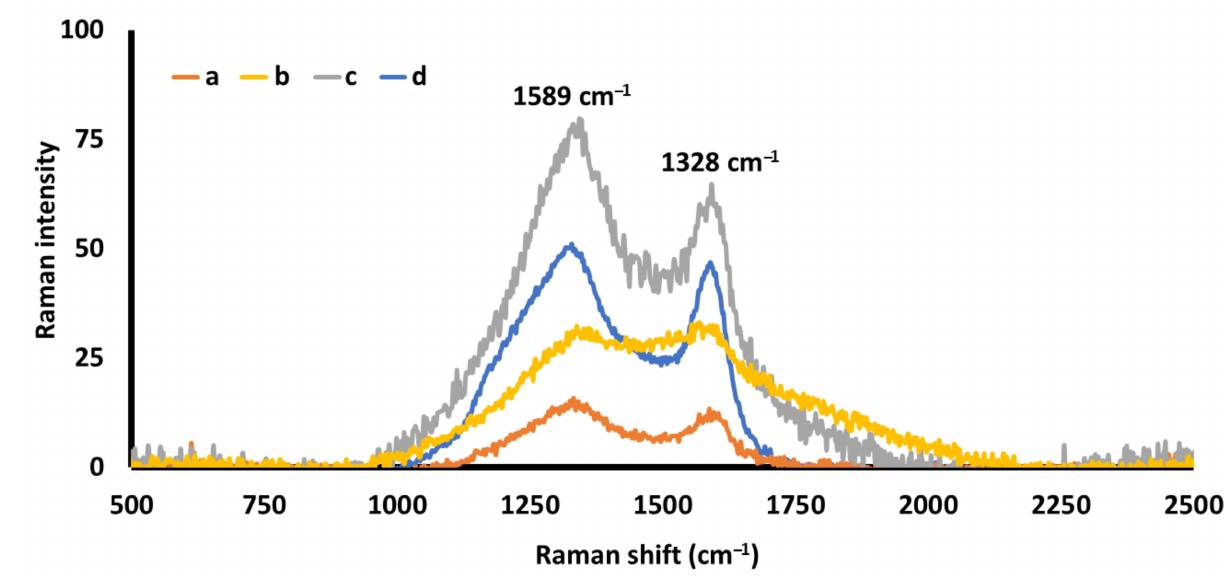
Figure 4. Raman spectra of the black solid material attached to the surface of molds #1 (a), #2 (b) and #3 (c), and activated carbon as the standard material